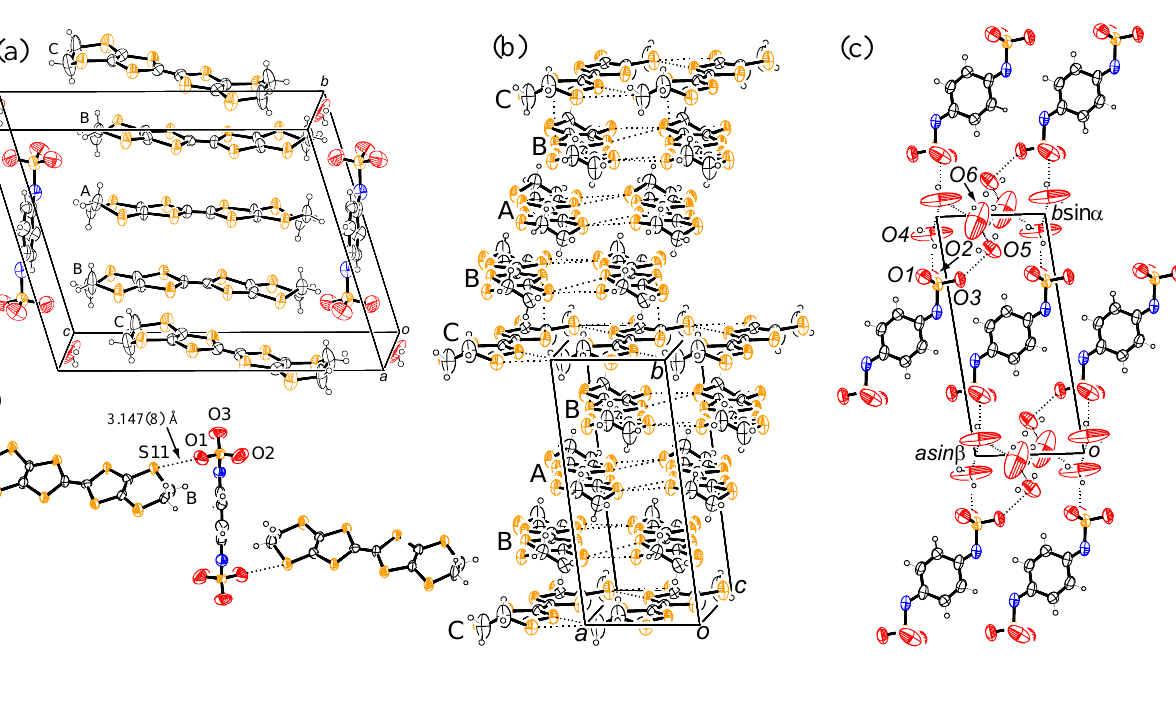
Figure 2. (a) Crystal structure of (ET) Dashed lines indicate short S···S distance (<3.70 Å). (c) 2D hydrogen-bonded network